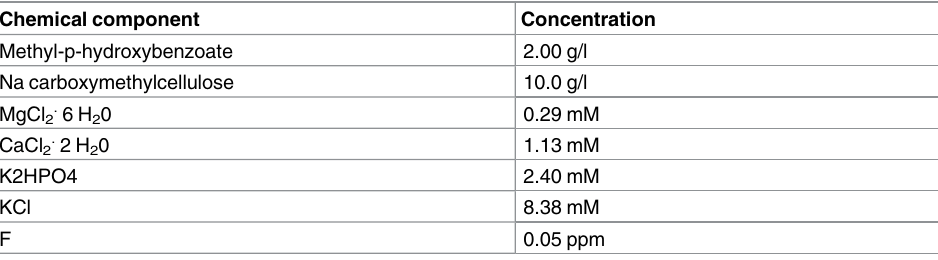
Table 1. Composition of artificial saliva